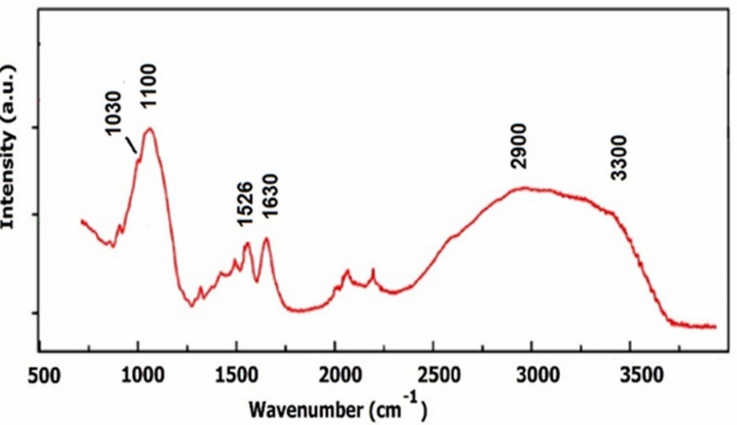
Figure 4. FTIR spectrum of